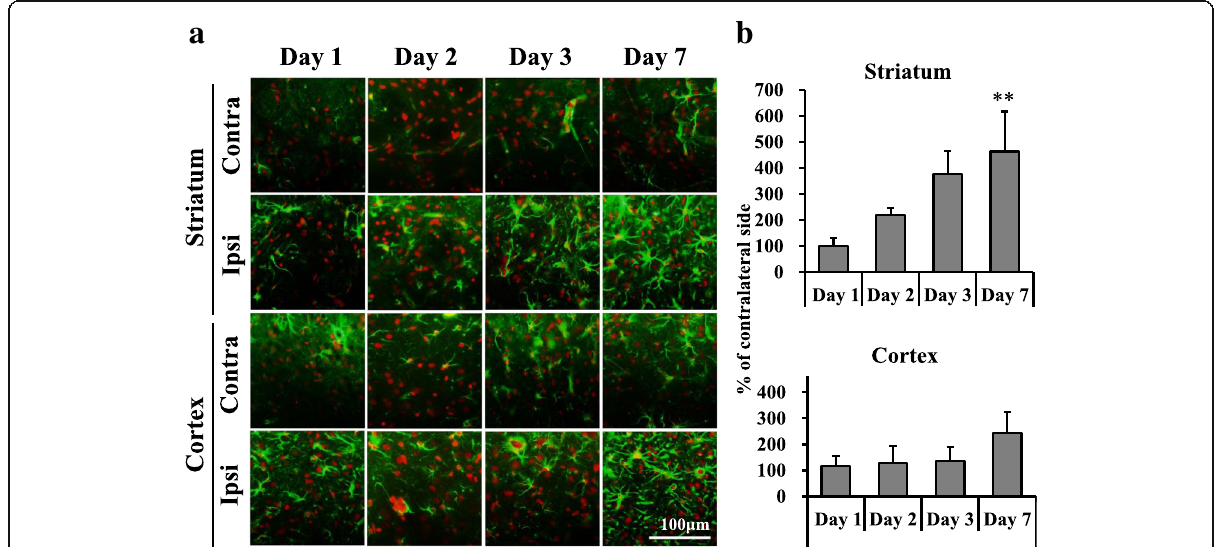
Fig. 6 Immunostaining with GFAP of the dorsal striatum and cerebral cortex after mild focal ischemia. a Merged immunostaining images were captured with GFAP (green) and PI (red) at 1, 2, 3, and 7 days after 20-min middle cerebral artery occlusion (MCAO). Scale bar, 100 μ m. Contra, contralateral side; Ipsi, ipsilateral side. b Graphs show % of the contralateral side, with values expressed as mean ± SD (day 1: n = 3, day 2: n = 3, day 3: n = 3, day 7: n = 3). Asterisks indicate significant differences compared with the contralateral side, ** p <